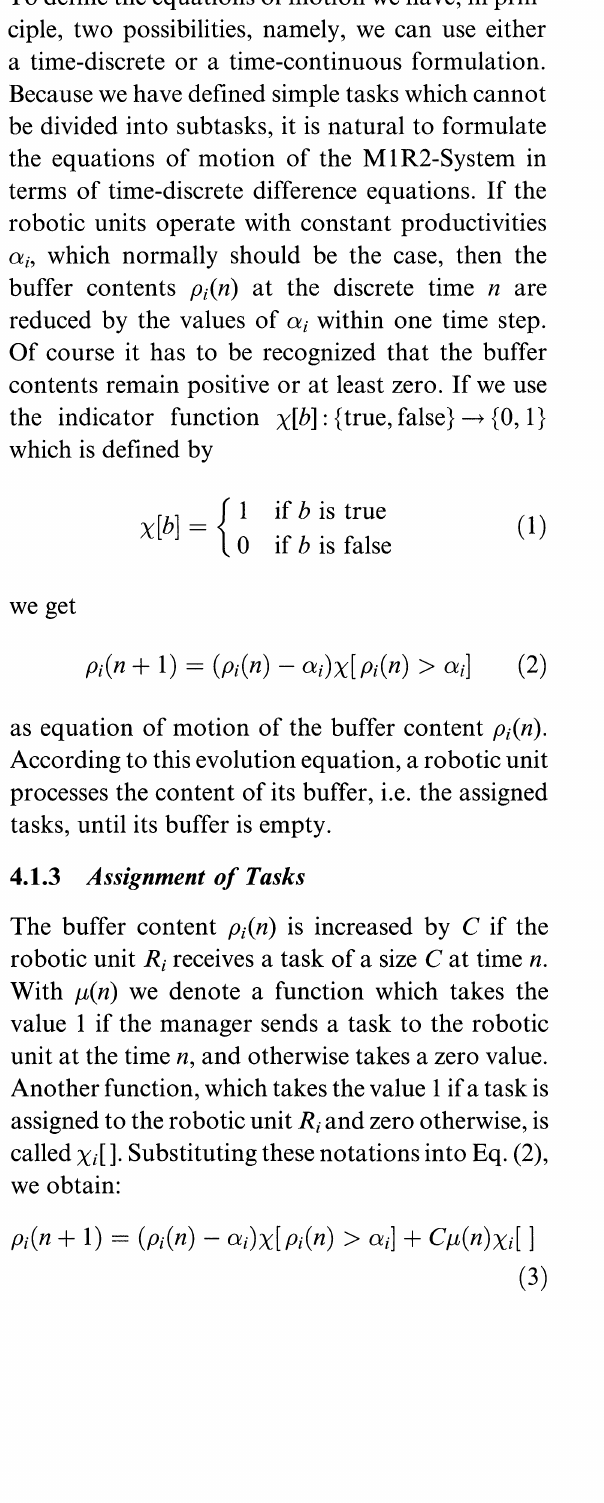
FIGURE Schematic representation of the